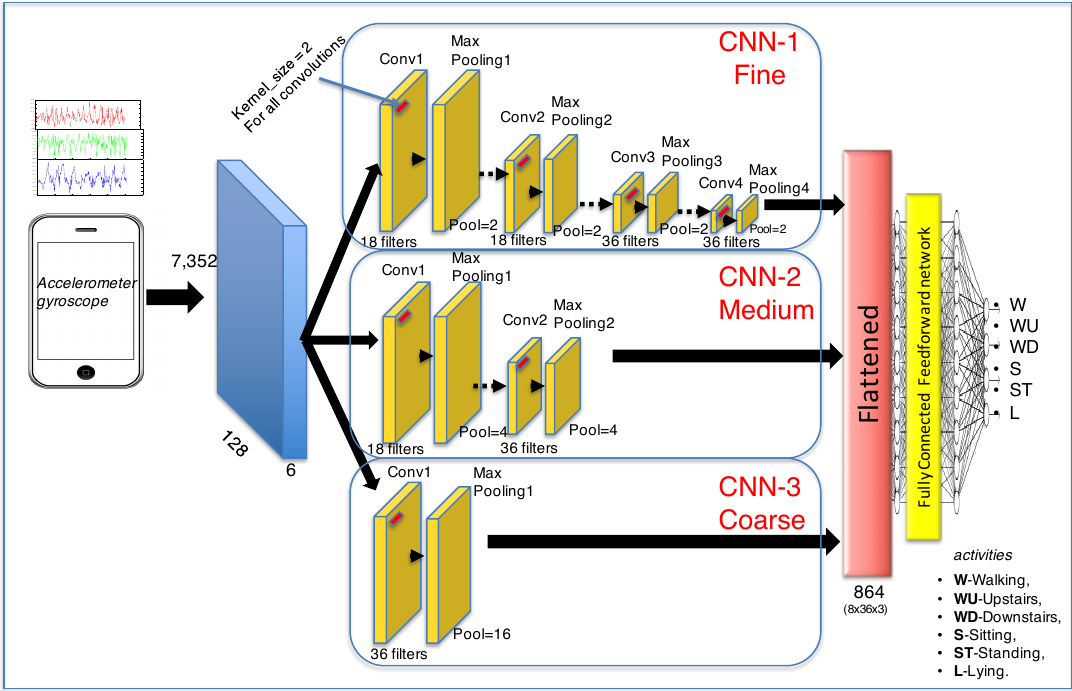
Figure 1. Proposed Coarse-fine convolutional neural network